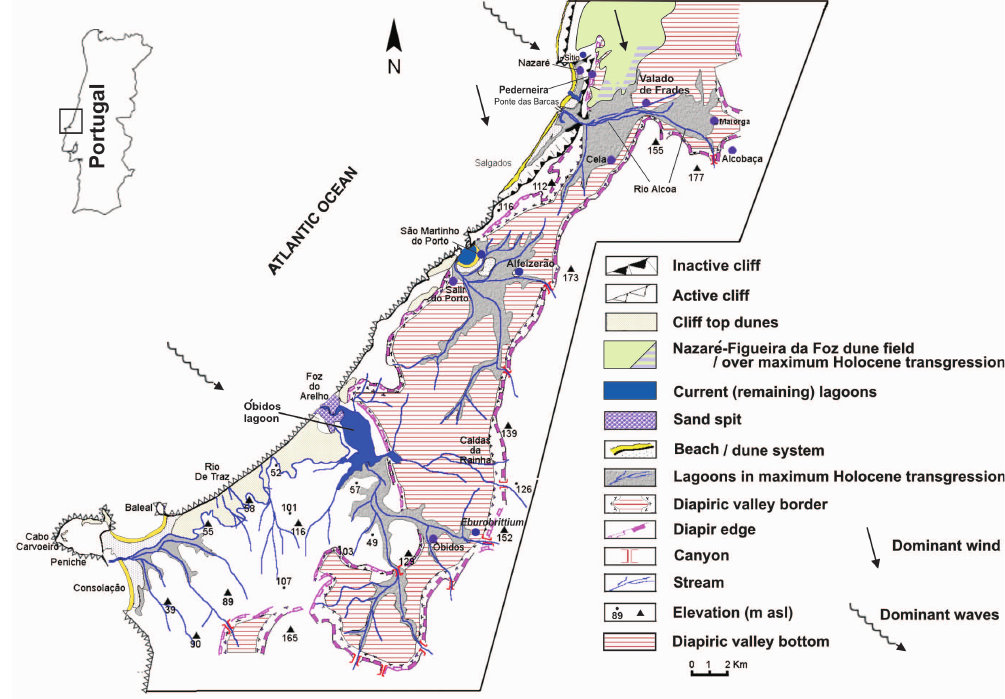
Fig. 2. Regional geomorphological map of the stretch of the western coast of Portugal where Lagoa de ´Obidos is located (Dinis et al.,